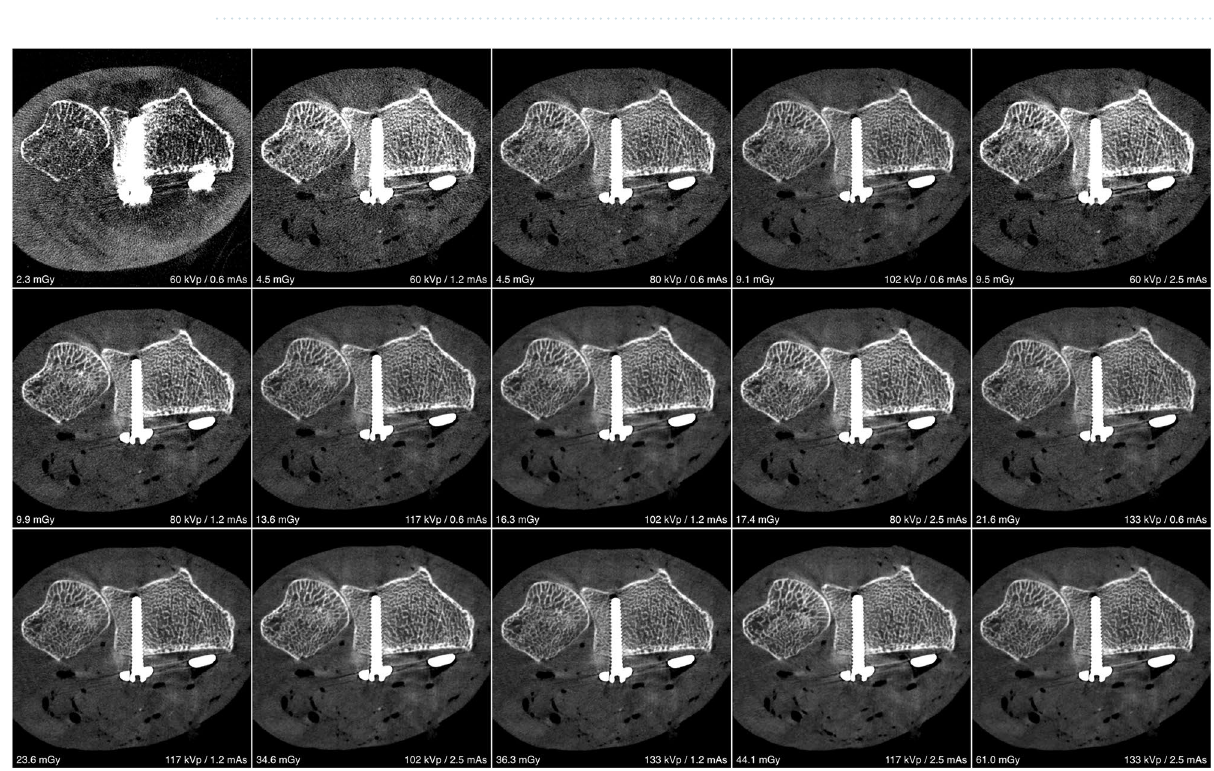
Figure 2. Bone image quality and intensity of metal artifacts by palmar plate osteosynthesis in ultra-high- resolution CBCT scan